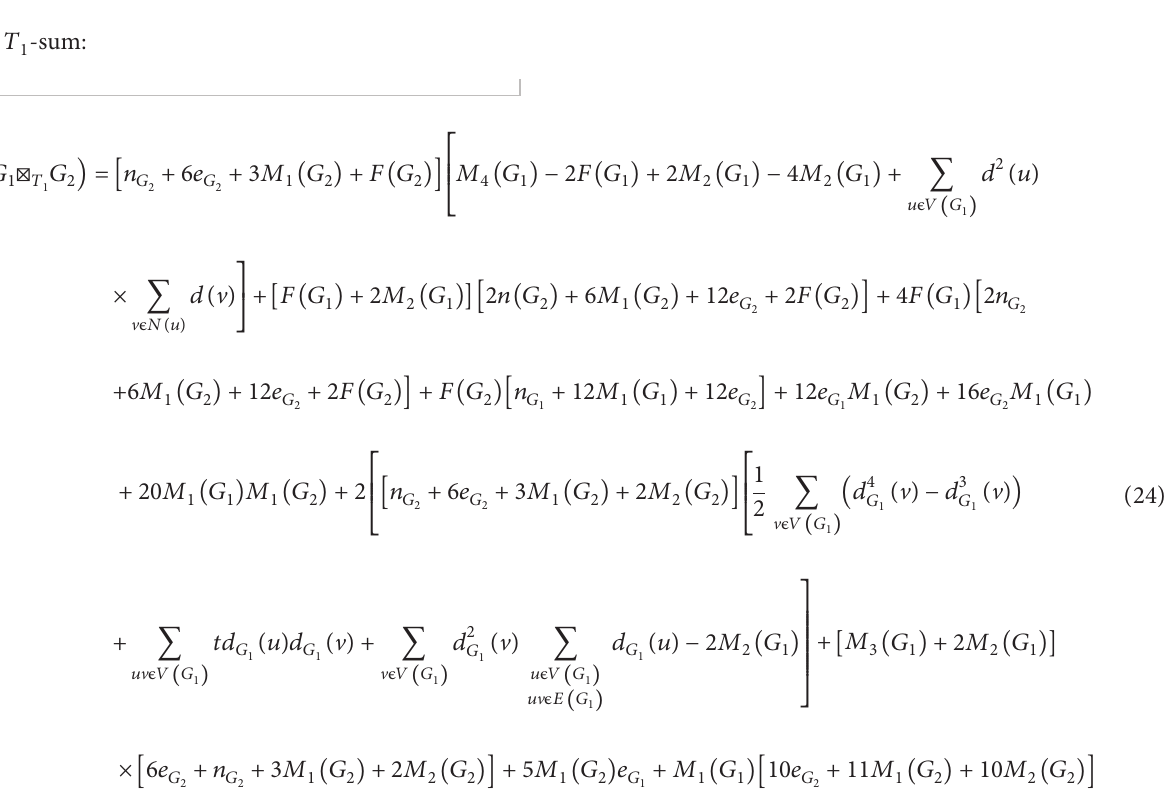
Figure 4: Graphical representation of HZ ( P colour,